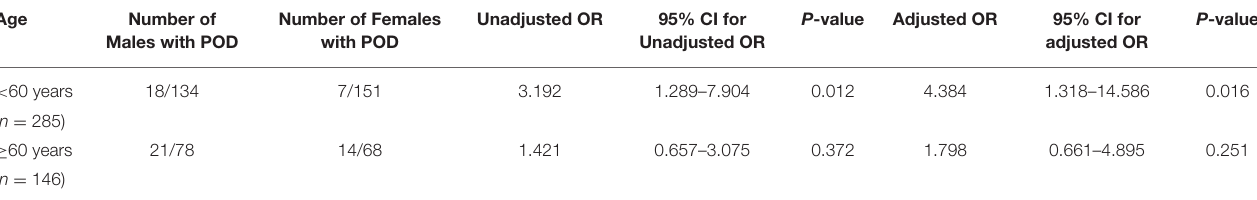
TABLE 4 | Stratification analysis by